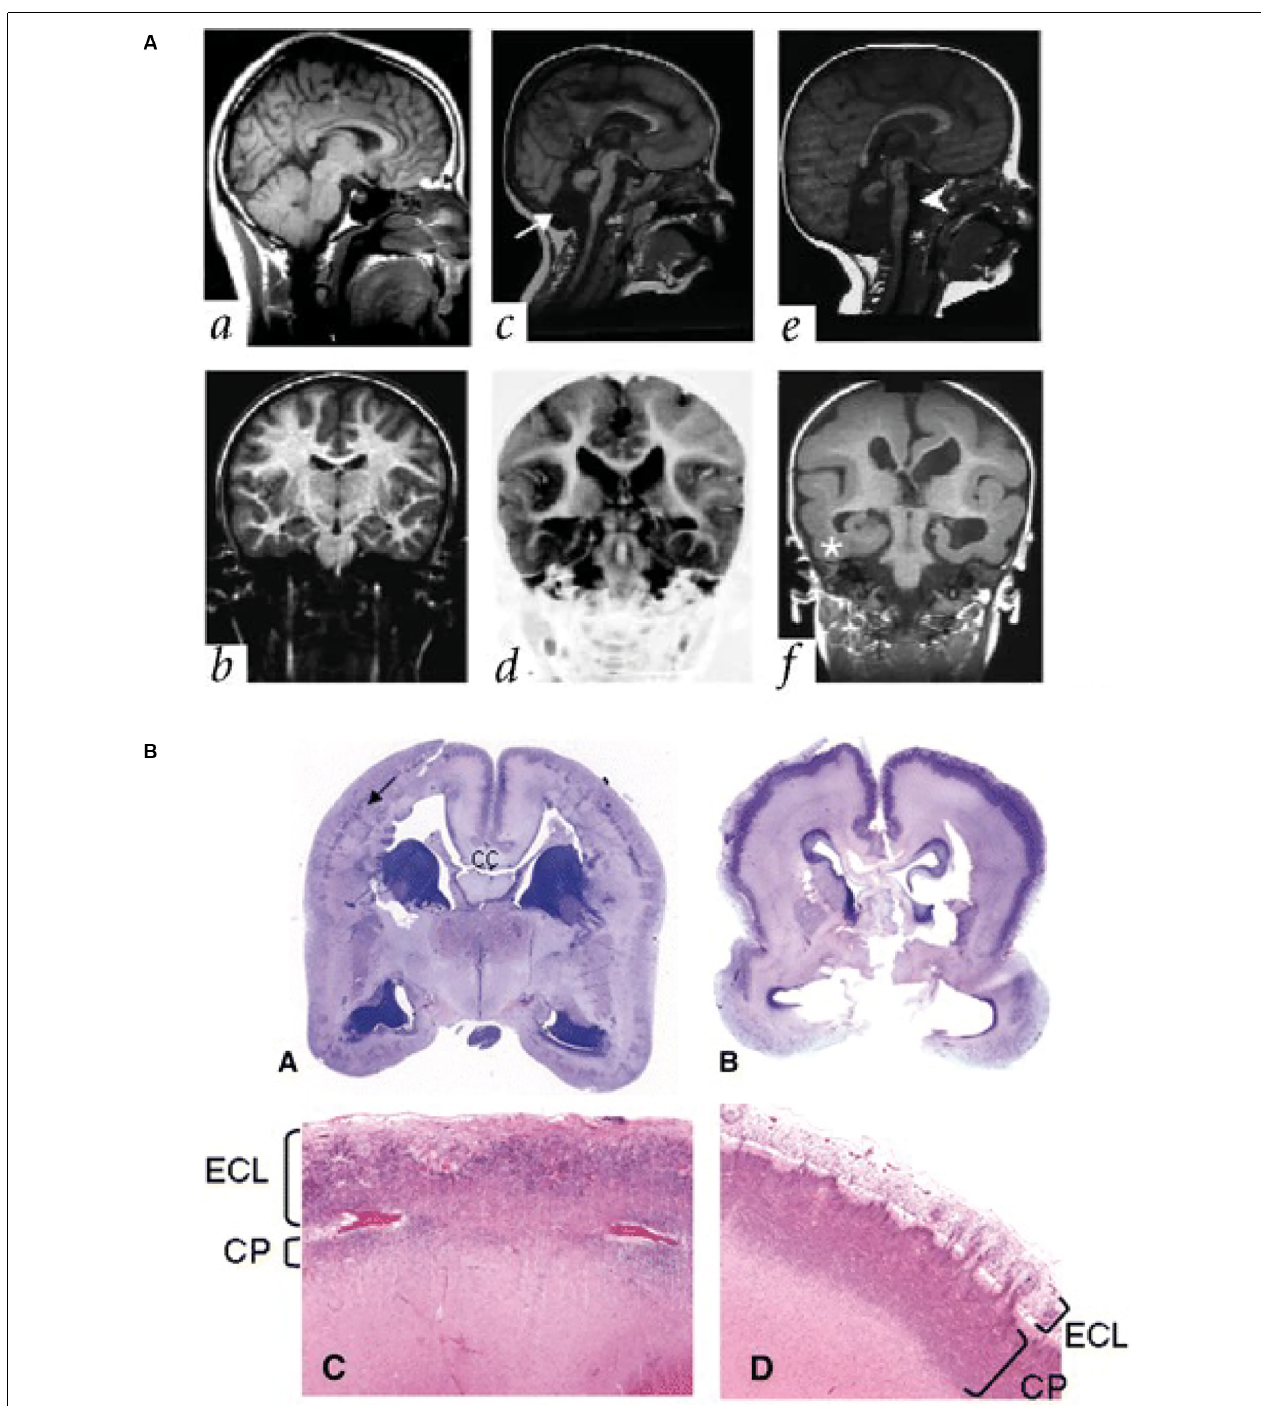
FIGURE 4 | Lissencephaly in patients with mutations in ECM and ECM-associated genes. (A) Parasagittal (upper panels) and coronal (lower panels) MRI from patients with a normally developing brain ( a,b ), and two patients with lissencephaly associated with RELN mutations ( c,d ; e,f ). Note the thickened cortex and reduced folding present. Adapted from Hong et al. (2000). (B) Images showing examples of cobblestone lissencephaly in a 19 pcw fetus with a POMT1 mutation ( A,C , left panels) and 26 pcw fetus with a POMGNT1 mutation ( B,D , right panels). The top panels show whole-mount sections of the brain. Arrow indicates impoverished cortical plate in the top left panel. The lower panels show higher magnification images of the cortical plate from these fetuses. Note the reduced size of the cortical plate (CP) and the thickened extracortical layer (ECL) in the lower left panel, but the thin ECL in the lower right panel. CC indicates the corpus callosum. Adapted from Devisme et al.